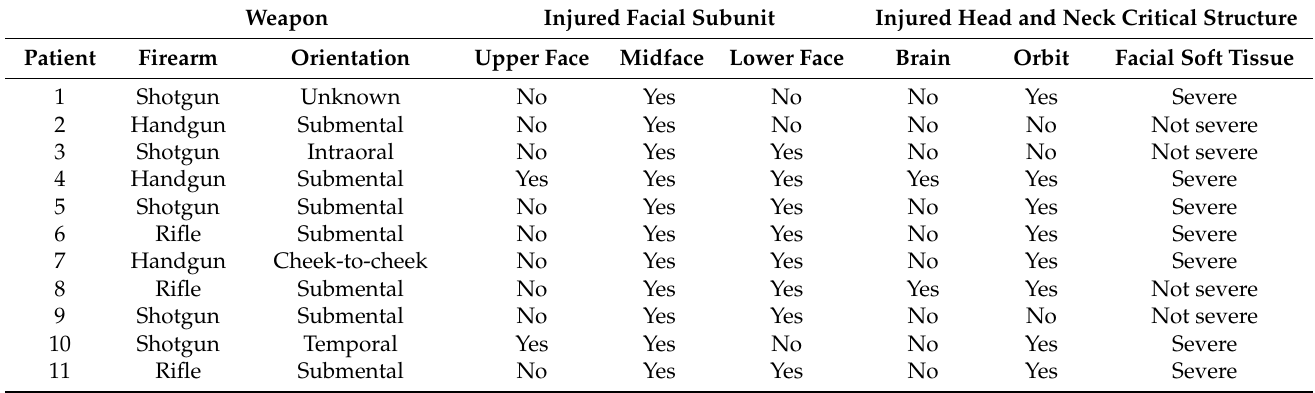
Table 2. Injury characteristics of patient cohort (N =